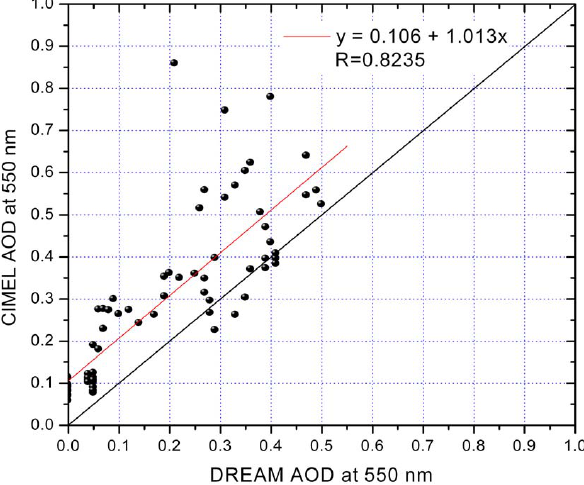
Fig. 6. CIMEL versus BSC-DREAM AODs at 550nm for dust cases observed within the period between 18–23 of May